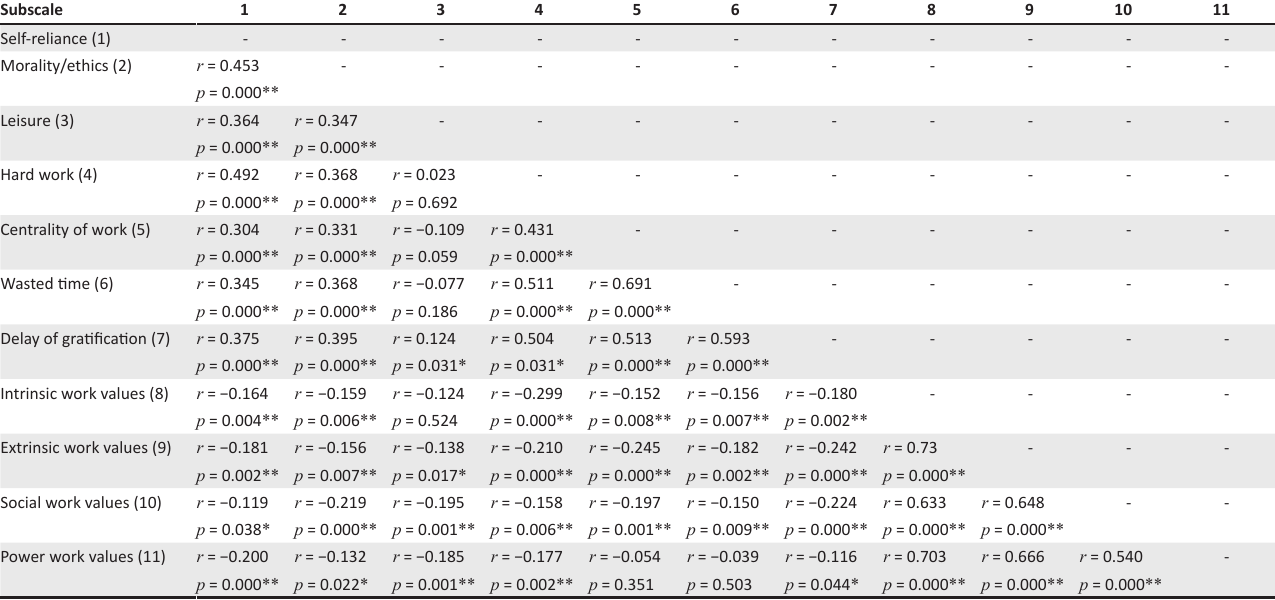
TABLE 4: Pearson product-moment correlations between measures of work values and work ethics.